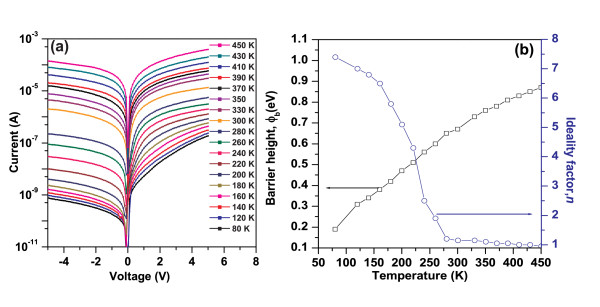
Current versus voltage plots and variation of barrier heights and ideality factor. (a) Current versus voltage plots of the InN NRs/n-Si diode at different temperatures. (b) Variation of barrier heights and ideality factor with temperature.